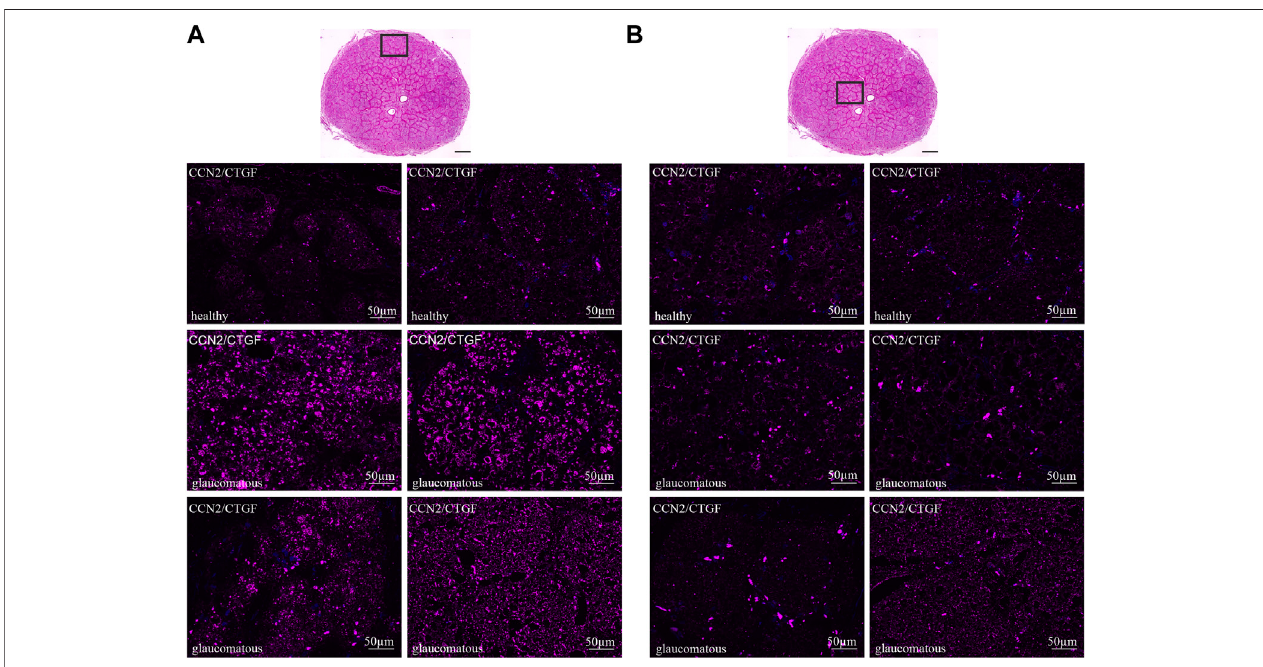
FIGURE4| CCN2/CTGFinthehealthyandglaucomatousONHofthehumaneye.TangentialcrosssectionwithH&Estainingin A and B representsthelocationof lower pictures within the ON indicated by the rectangle. (A) CTGF immunoreactivity (purple) in the border area of glaucomatous ON is increased compared to healthy control. (B) CTGF immunoreactivity is not altered in the central area of the glaucomatous ON compared to the healthy ON. Nuclei are stained with Dapi (blue).